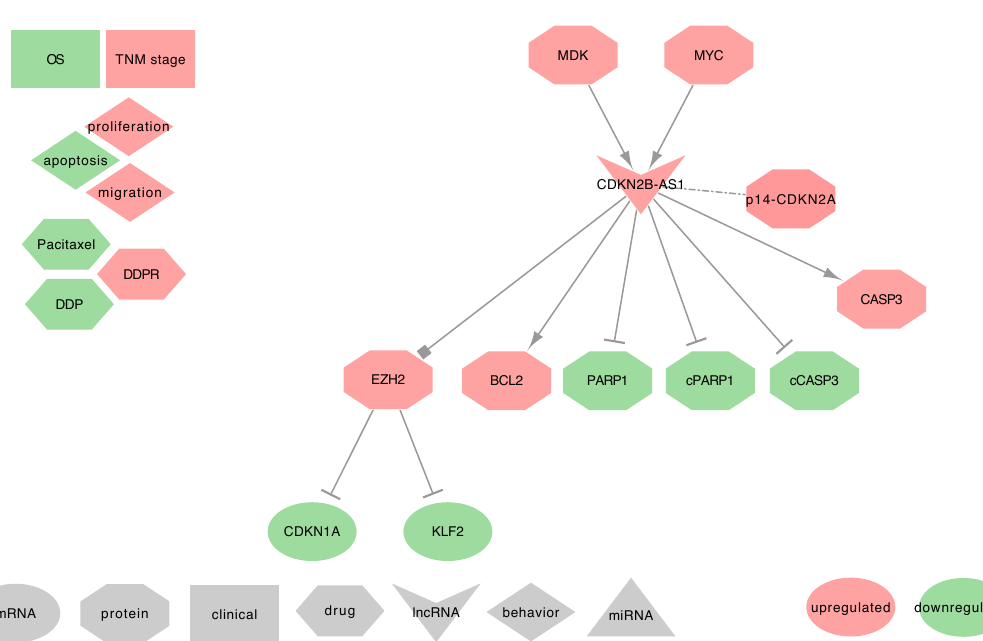
Figure 10. CDKN2B-AS1 in lung cancers: A network of lncRNA-miRNA-Protein interactions. Upregulated molecules are in green. Downregulated molecules are in red. Shape definitions are in grey. Gray arrows target the activated molecules. T-ended lines target the inhibited molecules. Square-ended lines represent a binding between molecules. Dashed-dot lines represent an association with unknown